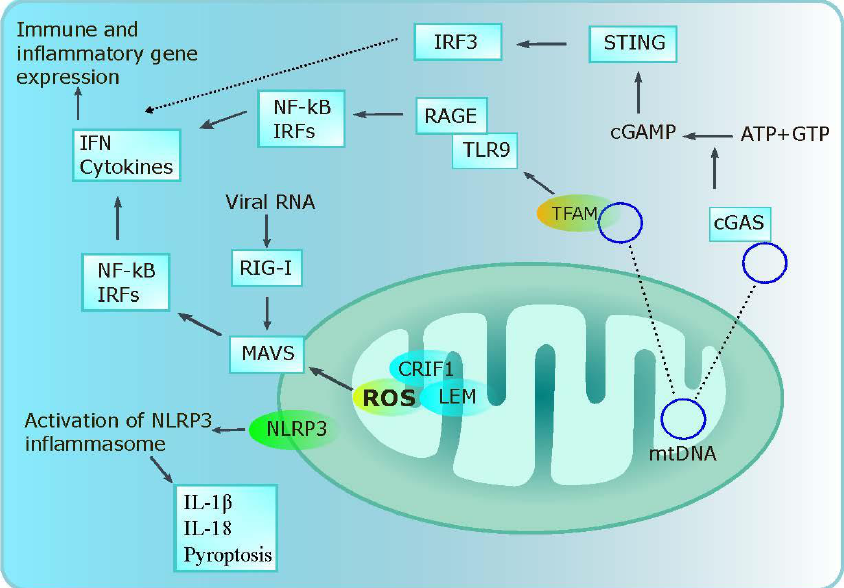
Figure 4. Mitochondria in immune regulation. Mitochondrial ROS through MAVS and NLRP3 enhance cytokine secretion. NLRP3 assists pyroptosis while the NFkB-based MAVS–cytokine axis enhances inflammatory gene expression. mtDNA and cGAS activate STING-based IRF3 and contribute to immune gene expressions. TFAM and mtDNA activate NFkB and IRFs to further immune responses. MAVS, mitochondrial antiviral-signaling protein; IRF, interferon regulatory factor; NLRP, NLRP domains containing protein; TLR, toll-like receptor; cGAS, cGMP-AMP synthase; RAGE, the receptor for advanced glycation end products.